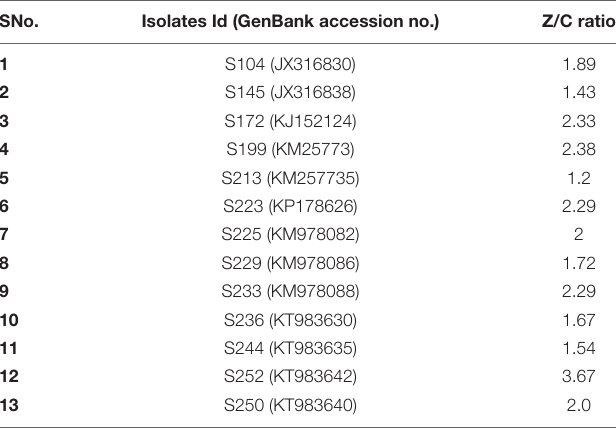
Z: Diameter of zone of clearance. C: Diameter of the